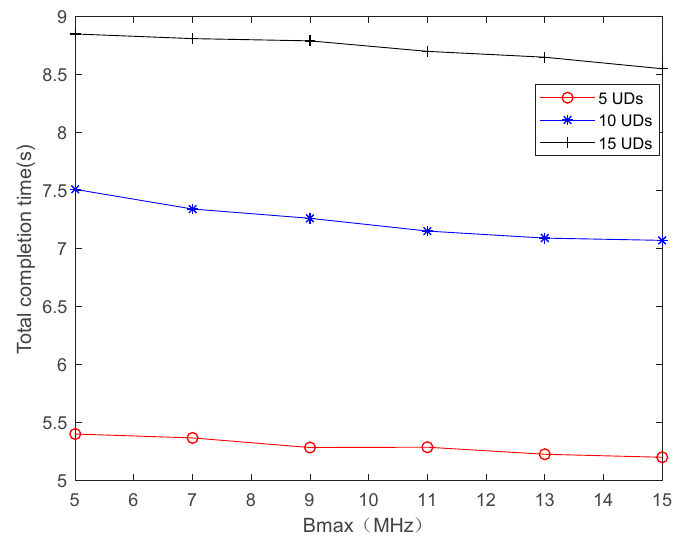
B . Figure 8. Total completion time T varies with B max .